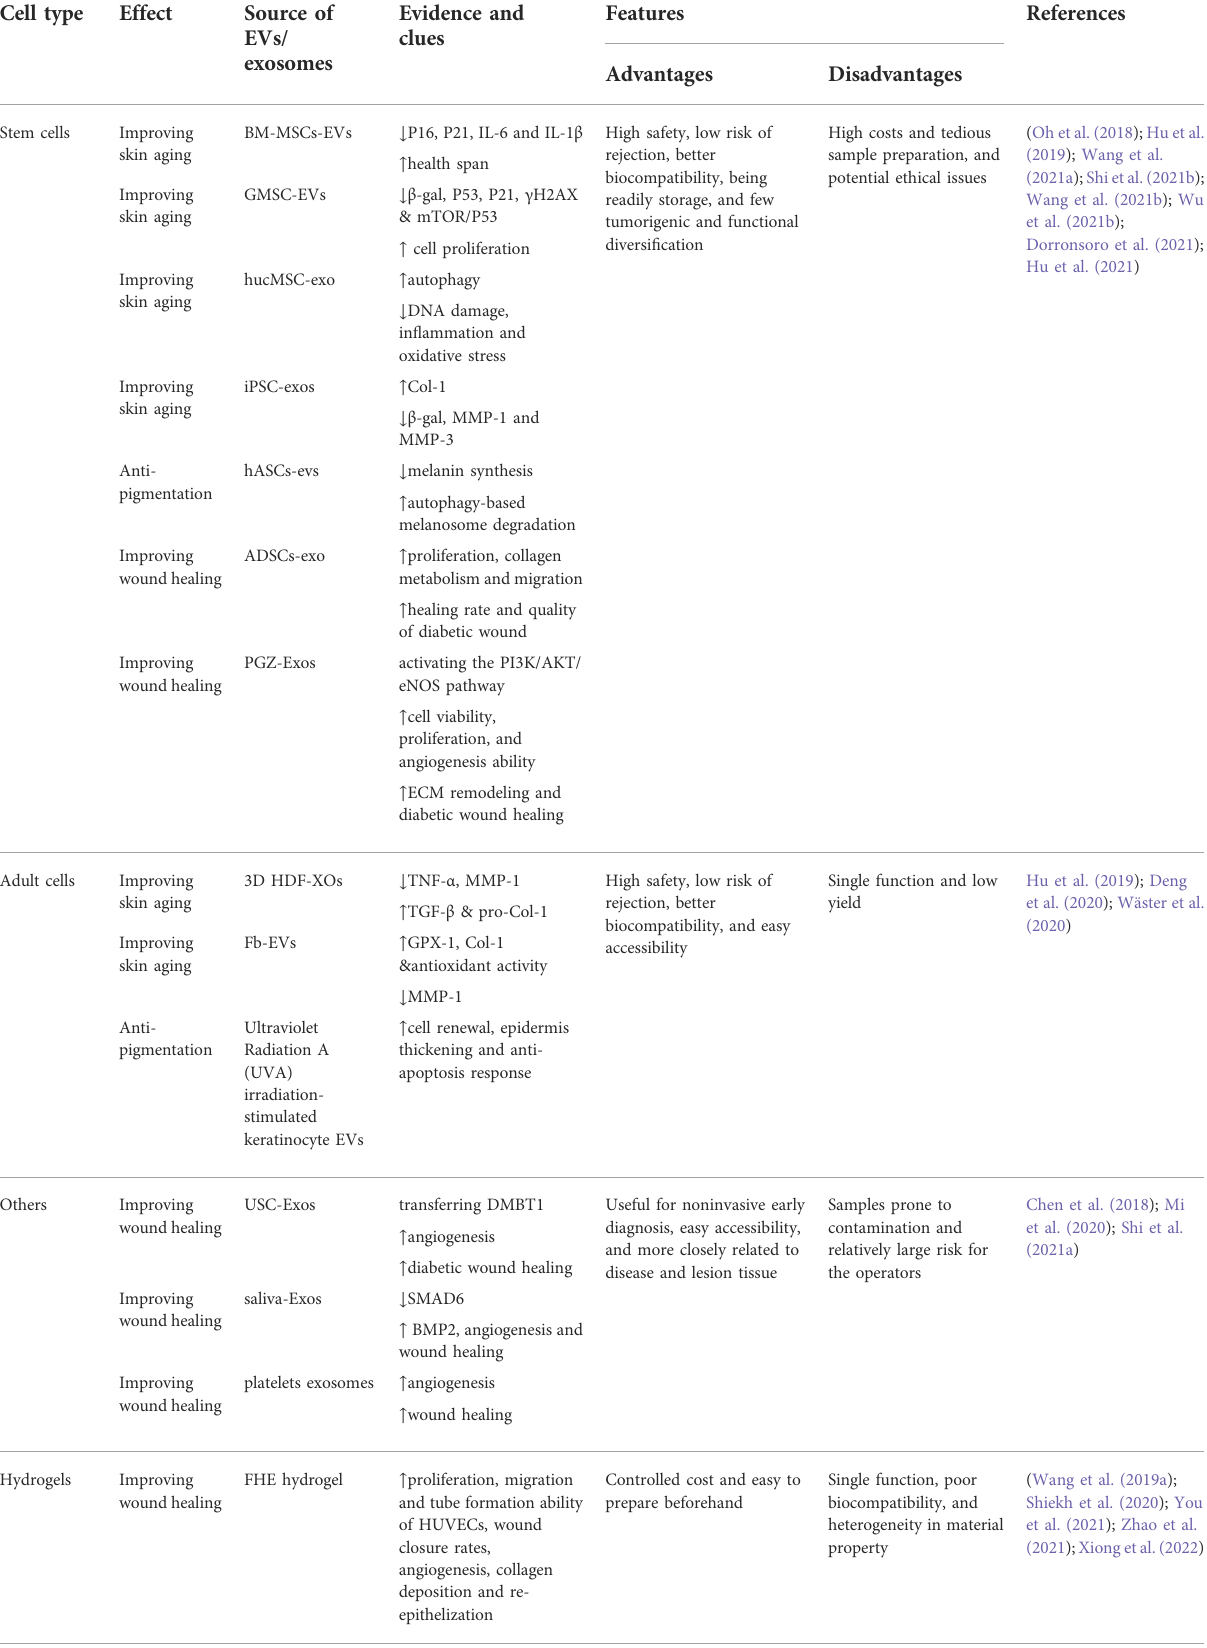
TABLE 1 Features of EVs in promoting wound healing, anti-aging, and